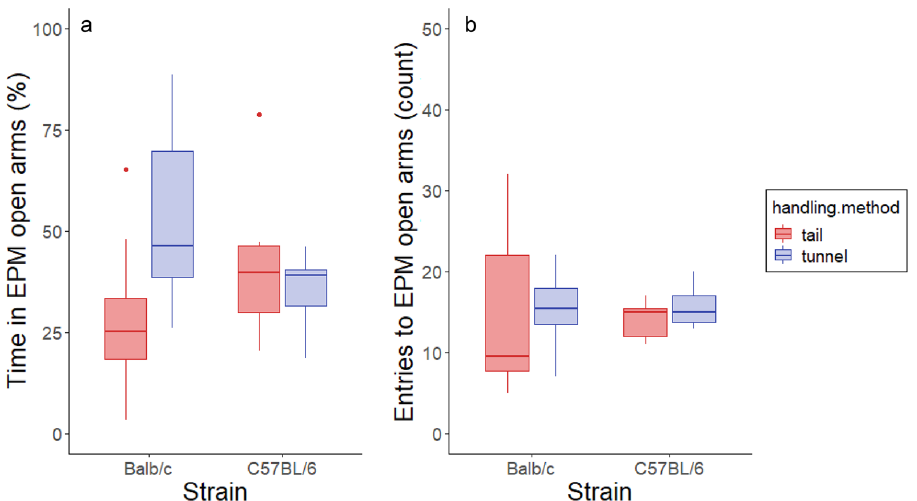
Figure 2. Behaviour on the elevated plus-maze. ( a ) Tail handled Balb/c mice spent less time in open arms of the EPM compared to tunnel handled mice while there was no effect of handling method in C57BL/6 mice. ( b ) Handling method had no effect on the number of open arm